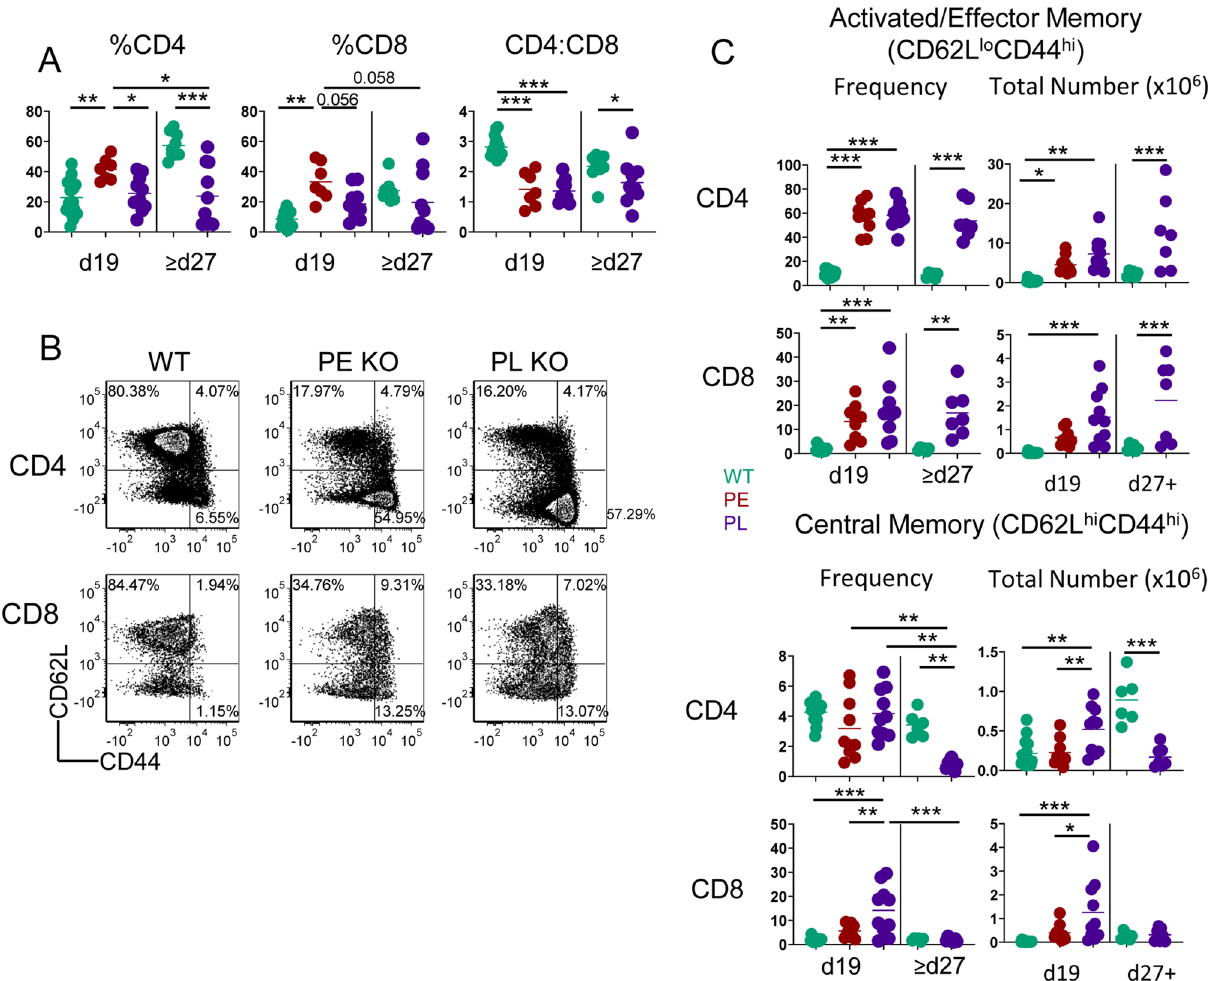
Figure 2. IL-2Rα-KO T cells express markers indicative of developing memory. ( A ) CD4 and CD8 T cell frequency of live B220-CD11b-CD11c-Gr-1-cells and the ratio of CD4:CD8 T cells in spleen are shown for 19-day-old and late endpoint (d27+) WT and IL-2Rα-KO mice. ( B ) Representative flow plots of CD44 and CD62L expression on spleen CD4 and CD8 T cells in 19-day-old WT and IL-2Rα-KO mice. ( C ) Frequency and total number of CD4 and CD8 T cell activation state in 19-day-old and late endpoint (d27+) WT and IL-2Rα-KO mice. Statistics: one-way ANOVA with Benjamini–Hochberg FDR correction; *p < 0.05, **p < 0.01, ***p < 0.001; n = 5–10 mice per experimental group. Non-significant comparisons are not shown. For total number, comparisons between mice of different ages are not shown to due differences in mouse